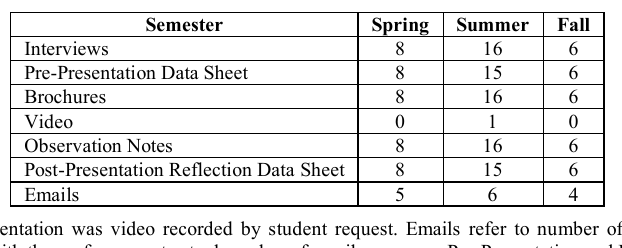
Table 2. Type and Amount of Data Collected by